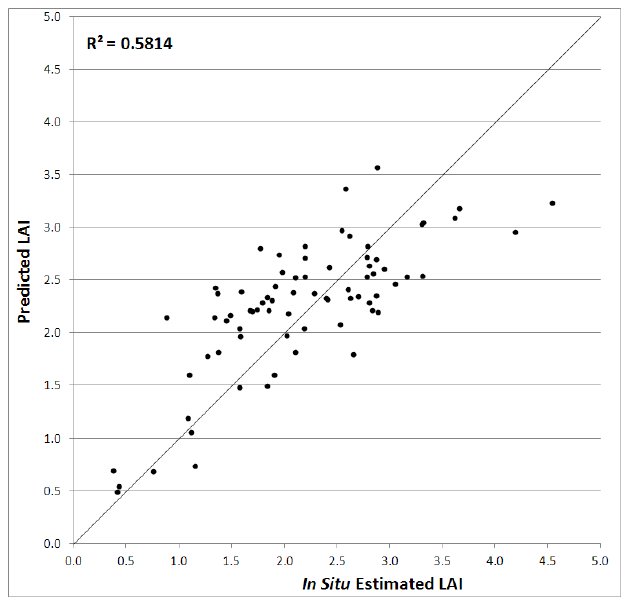
Figure 13. Scatter around the 1:1 line may be partially due to the time lag between the acquisition of the LiDAR data ( i.e. , summer 2007) and in situ data collection ( i.e. , summer 2011). This phenomenon may have most affected younger plots, which had potential to gain most biomass and leaf area. Figure 13. Predicted versus in situ estimated LAI values for n = 75 validation